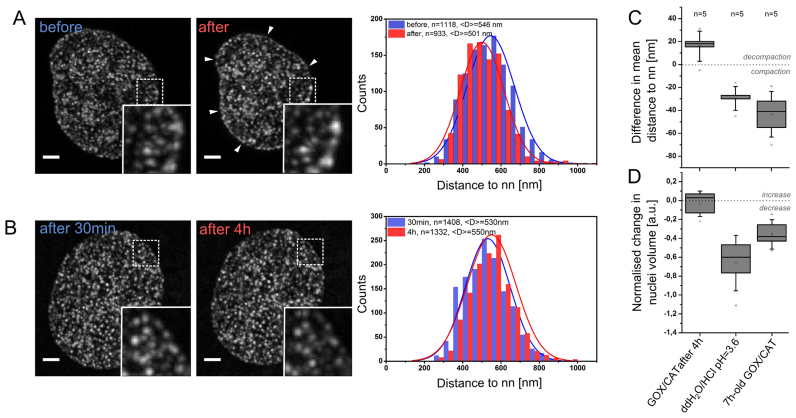
Effect of acidic imaging media on chromatin structure and nuclear volume. Nascent DNA was labeled with Alexa 555, and imaged by 3D confocal microscopy followed by image deconvolution. (A) Nearest neighbor (nn) analysis of Alexa 555 foci before and after 10 min of incubation in ddH2O/HCl buffer of pH 3.6, demonstrating shrinking of cell nuclei (arrows). (B) Cells were embedded in localization-microscopy buffer containing glucose oxidase, catalase and 10% glucose. 3D confocal microscopy was performed immediately after embedding (pH close to neutral) and after 4 h (pH ∼ 3.7, for details see Figure 3A, Supplementary Figure S4). Maximum Z-projections are presented. Scale bar, 2 μm. Centroid fitting enabled sub-pixel accurate foci localization and nearest neighbor (nn) analysis of chromatin-bound reference ‘points’. Representative examples of graphs are presented. The number of foci before and after the treatment with the respective average distance <D> are indicated. (C) Difference in an average nearest neighbor distance for: (i) an addition of ddH2O/HCl (pH 3.6, as in A); (ii) imaging buffer containing glucose oxidase undergoing acidification over 4 h (final pH ∼ 3.7, as described in B); and (iii) an addition of a 7 h-old imaging buffer containing glucose oxidase (pH ∼ 3.7). (D) Normalized change in nuclear volume for respective conditions. Crosses correspond to outliers, squares denote mean value, boxes indicate the 25 and 75 percentile range. Nn analysis of >15 000 Alexa 555 foci in total was performed in 15 cells.